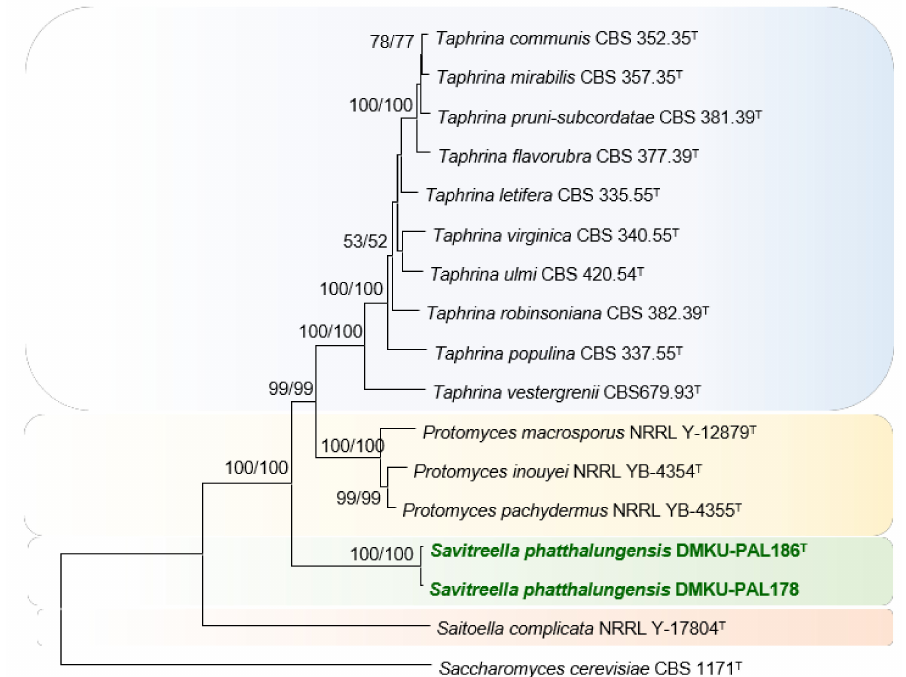
Figure 2. Phylogenetic tree based on the combined sequences of the SSU rRNA gene, ITS regions and the D1/D2 domains of the LSU rRNA gene, showing positions of Savitreella phatthalungensis sp. nov. with respect to closely related species. The tree backbone was constructed with the neighbor-joining method by MEGA software. Numbers at the node indicate percentages of bootstrap sampling (BP) of the NJ and ML analyses, derived from 1000 samples. All positions containing gaps and missing data were eliminated, resulting in a total of 4392 positions in the final dataset. Saccharomyces cerevisiae CBS 1171 T was used as outgroup in these analyses. Bar , patristic distance of